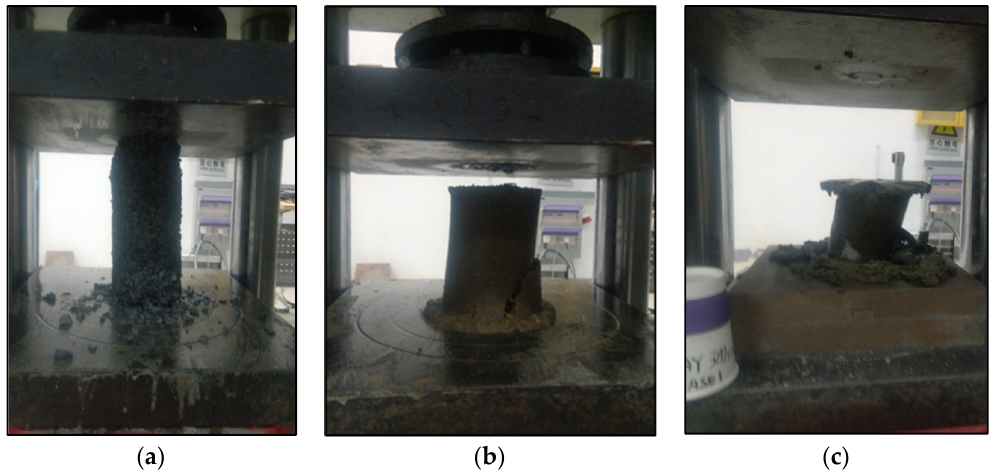
Figure 4. Failure of specimens without cracking behavior: ( a ) gravel; ( b ) sand; and ( c ) clay